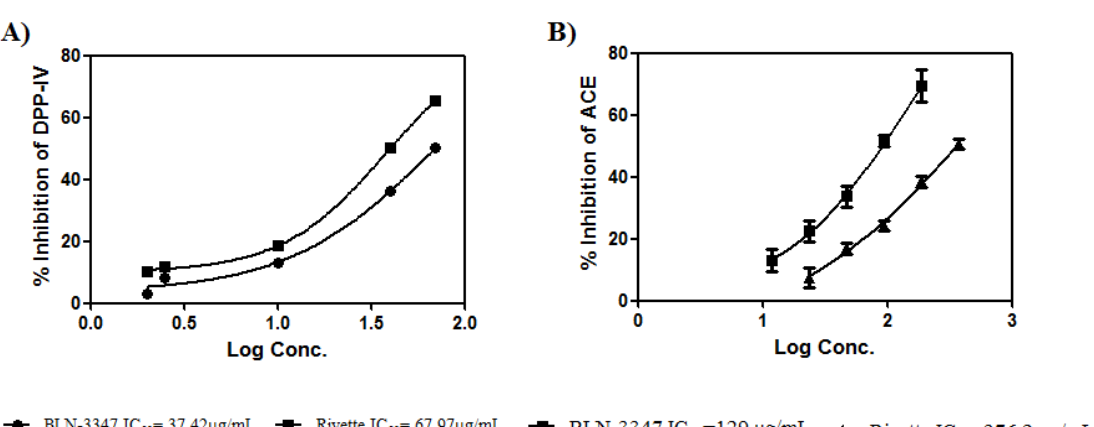
Figure 4. ( A ) DPP-IV (dipeptidyl peptidase-IV) inhibition activity of protease inhibitors (PIs) extracted from defatted meal